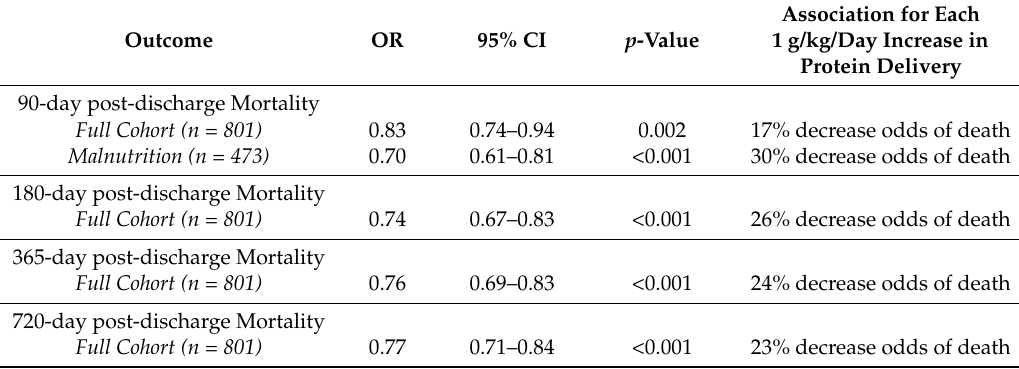
Table 2. Associations between Protein Delivery and post-hospital mortality outcomes. Outcome